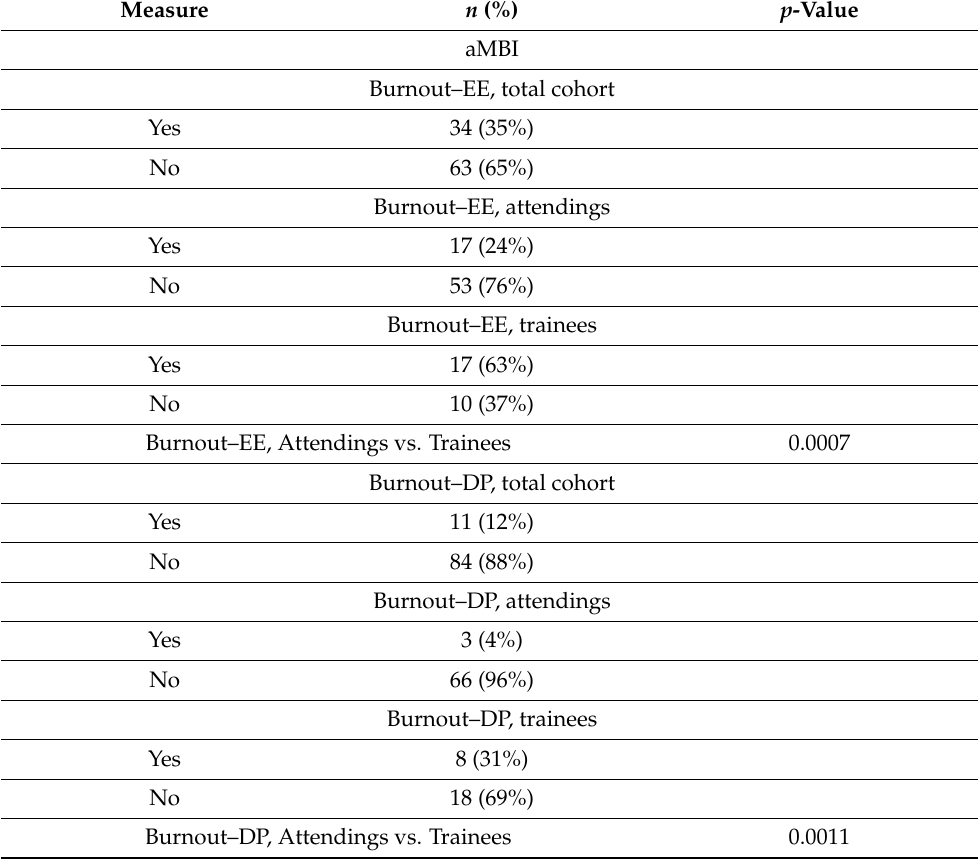
Table 2. Survey Responses for Burnout